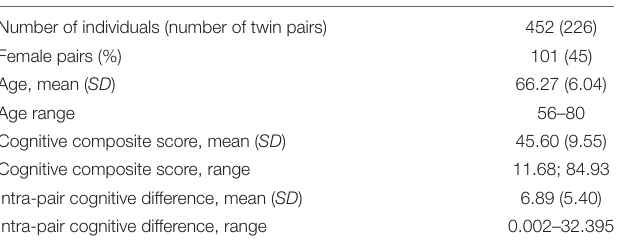
TABLE 1 | Characteristics of the study